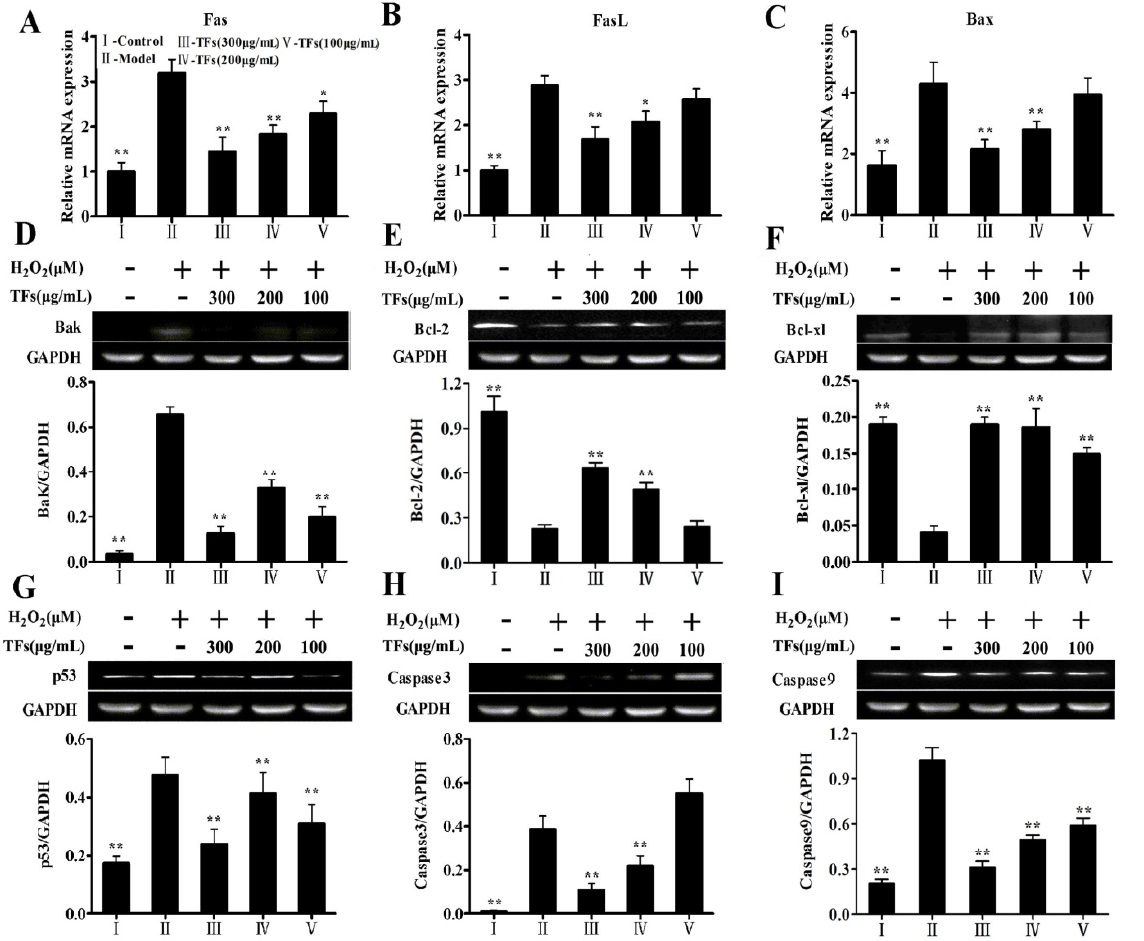
Figure 6. Effects of the TFs on the gene expressions of Fas ( A ), FasL ( B ), Bax ( C ), and protein expressions of Bak ( D ), Bcl-2 ( E ), Bcl-xl ( F ), p53( G ), caspase-3 ( H ) and caspase-9 ( I ). Values are expressed as mean ± SD ( n = 5). * p < 0.05 and ** p < 0.01 compared with model group.